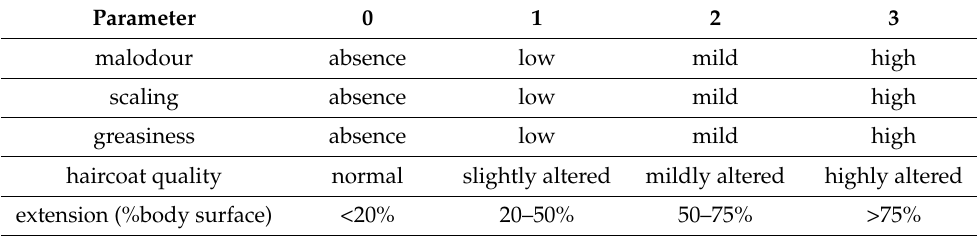
Table 1. Grading scale used to evaluate skin lesions in dogs with keratinization disorders. The clinical score was obtained by adding the different scores and ranged between 0 and